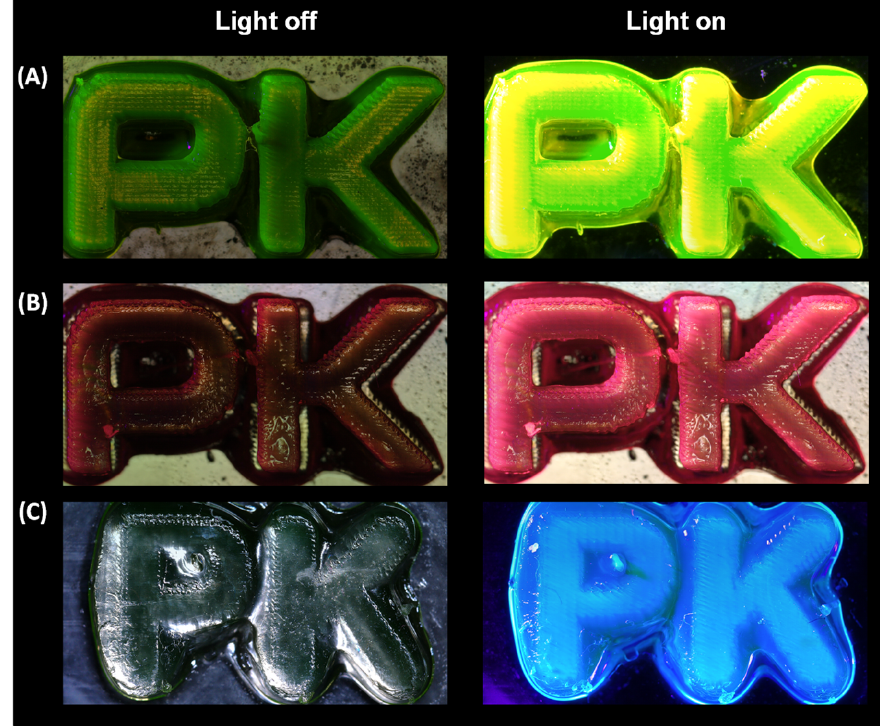
Figure 4. Print comparison obtained by NEJE laser engraver printer. Comparison was made with light off and light on for: ( A ) BODIPY; ( B ) Eu1; and ( C ) Coumarin 1.